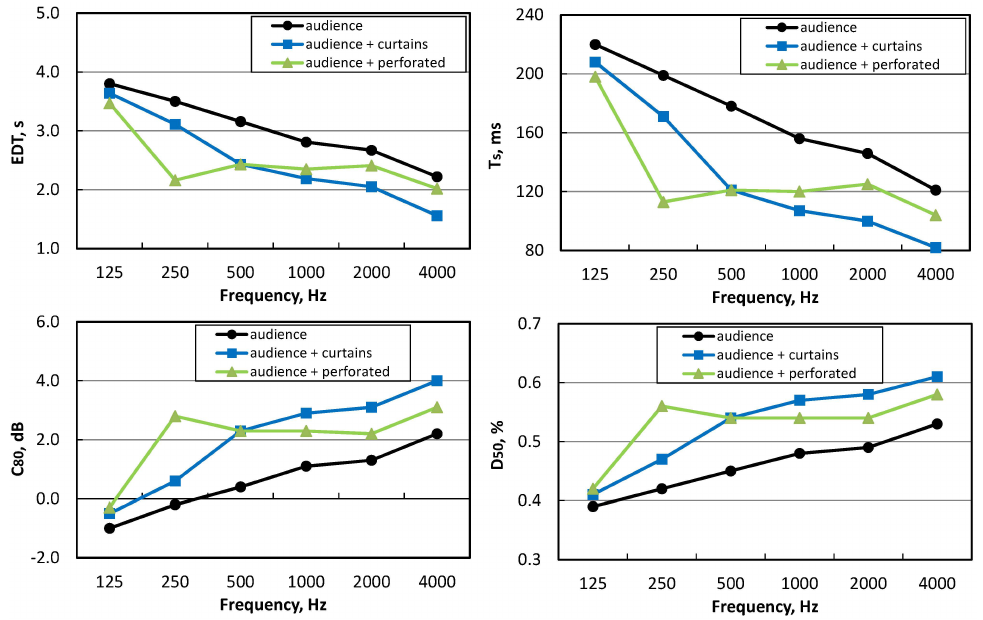
Figure 7. Simulation results obtained considering the presence of the audience (full occupancy), and with the acoustic absorbing curtains or perforated panels along lateral walls and in the